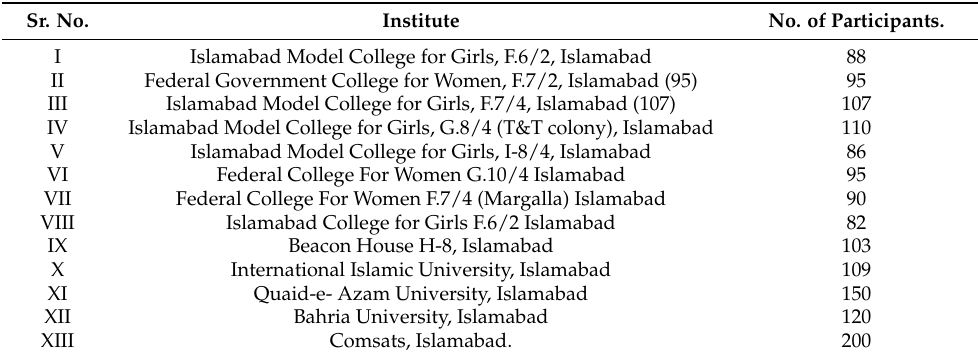
Table 6. The institutes visited by the doctors’ team to create awareness in the urban population of Islamabad.